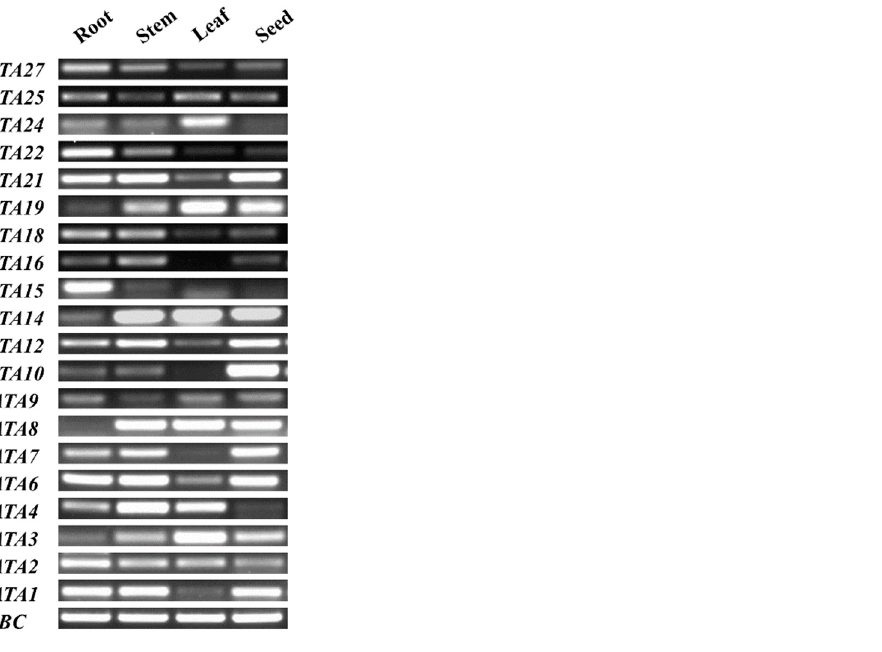
Figure 6. RT-PCR analysis of BdGATA expression in different tissues of Brachypodium distachyon.